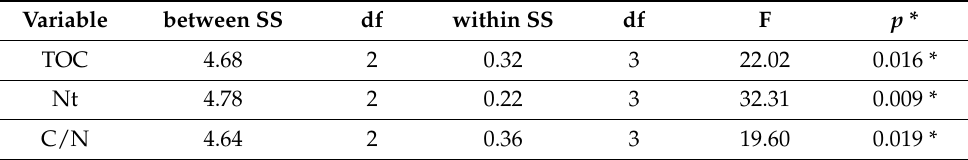
Table 4. Analysis of variance (k-means method) for TOC, Nt and C/N. Variable